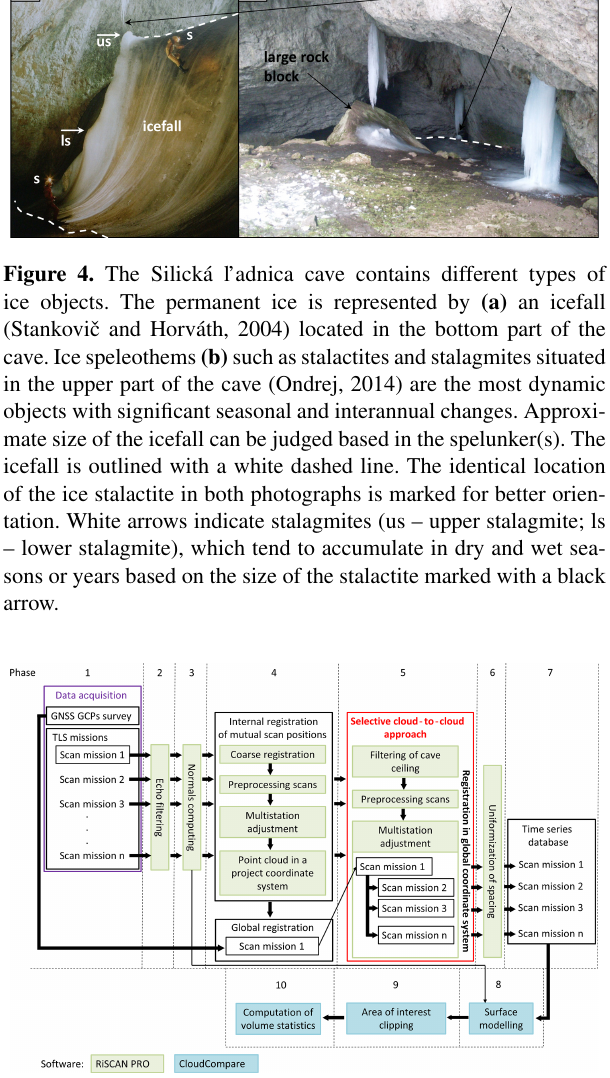
Figure 5. The workflow for generating a time series database and framework of data